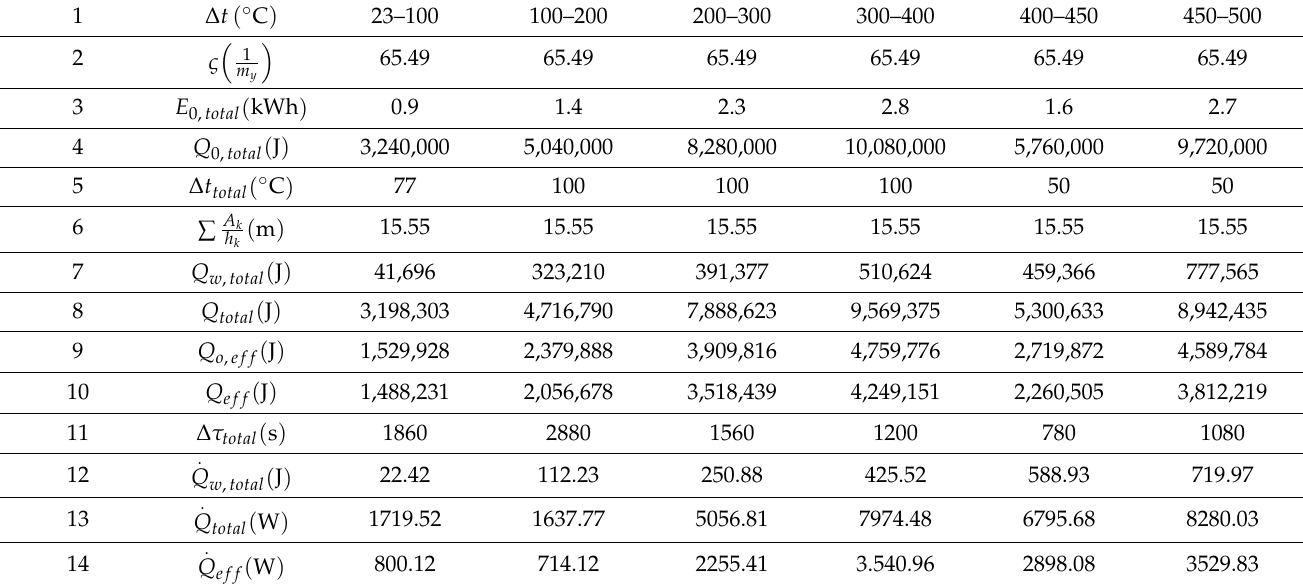
Table A3. Prototype, unpainted—scale 1:1.